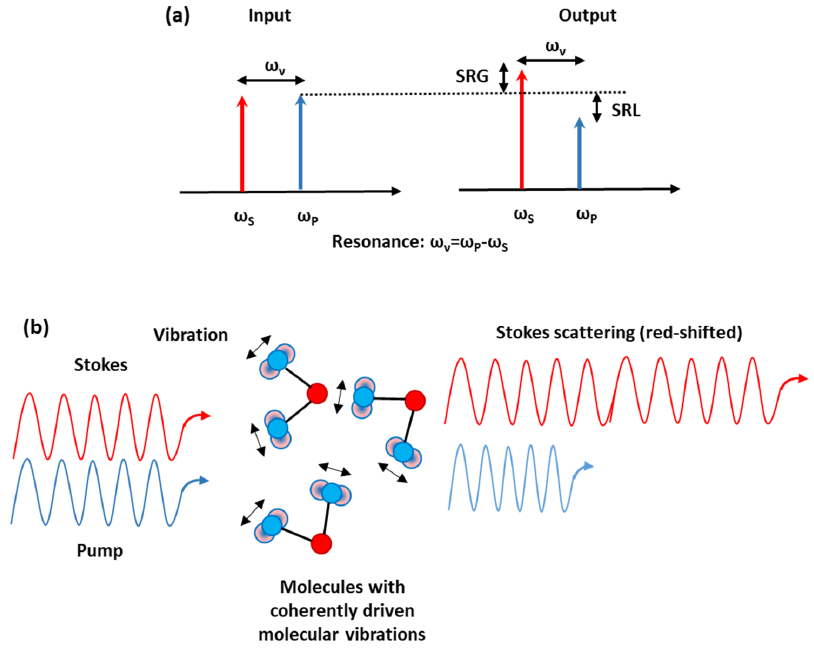
Figure 1. ( a ) SRS modalities: SRG, stimulated Raman gain; SRL, stimulated Raman loss; ( b ) inelastic scattering of probe photons obtained from vibrationally-excited molecules interfering